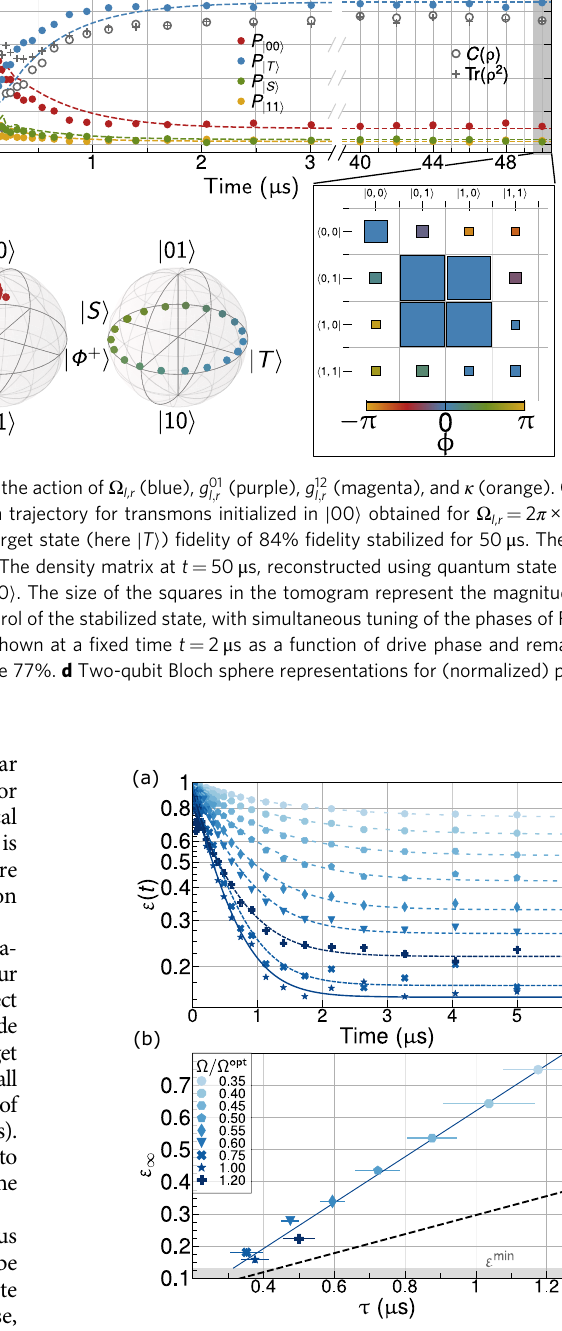
Fig. 4 Trade off-free performance scaling. a Measurement of preparation error as a function of time, ε ( t ), for different Rabi drive amplitudes of Ω 01 . l ; r b Parametric plot of the steady-state error ε ∞ and the stabilization time constant τ , obtained from fi tting the data in ( a ) showing the expected linear scaling. The minimum ε ∞ and τ are measured at Ω opt (cid:5) 1 : 5 κ . The minimum l ; r error ε min is close to theoretically achievable value for experimental κ 1 (shown as the gray fl oor), (Supplementary Fig. 11). The dotted line is the error-time scaling obtained from a simulation of Eq. (1) and has slope equal to 1/ T B with T B = 3.38 μ s, independent of drive amplitudes, in accordance with the semi-classical estimate discussed in the “ Methods ” section. The deviation of experimentally observed slope from 1/ T B is quantitatively explained by including a residual drive detuning and imbalance in the sideband amplitude (Supplementary Fig.